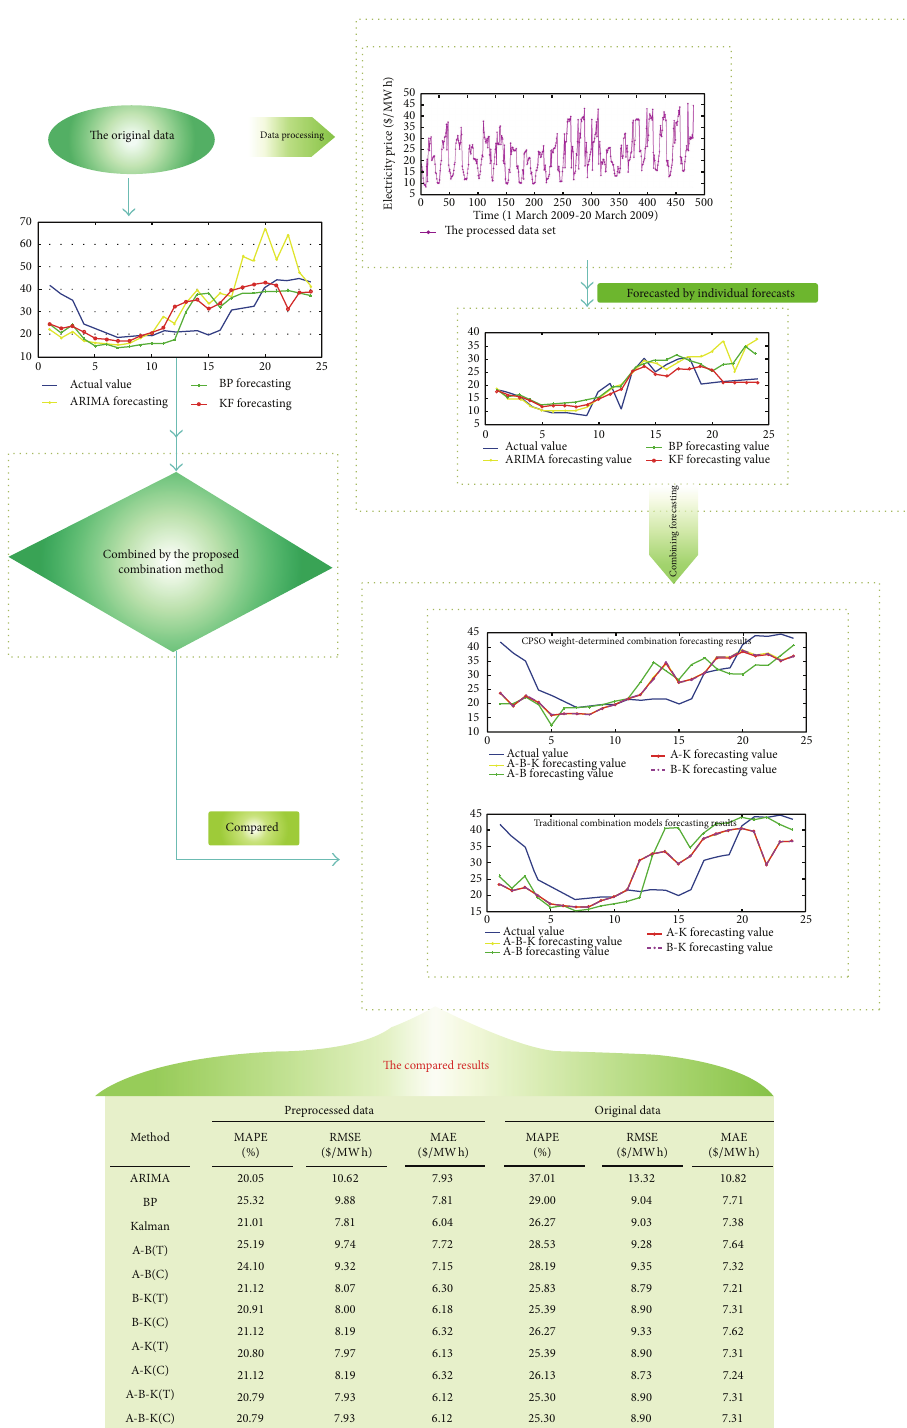
Figure 8: The results of the simulation